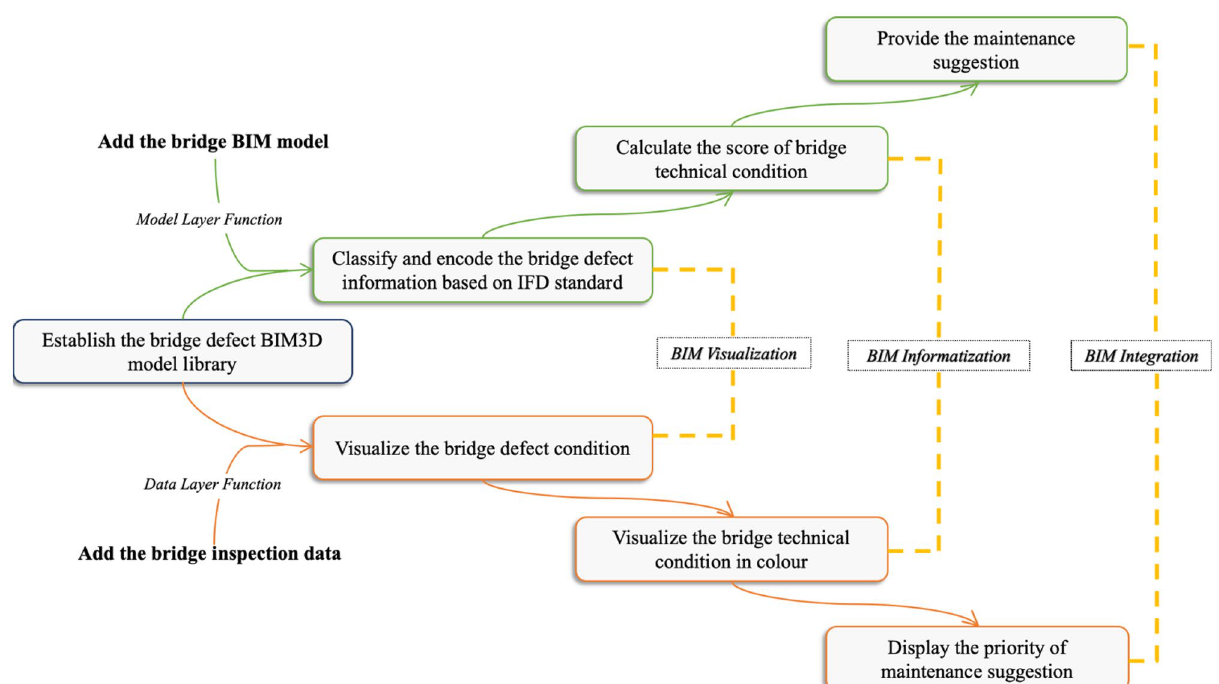
Figure 2. Utilization flowchart of the BIM-based bridge maintenance